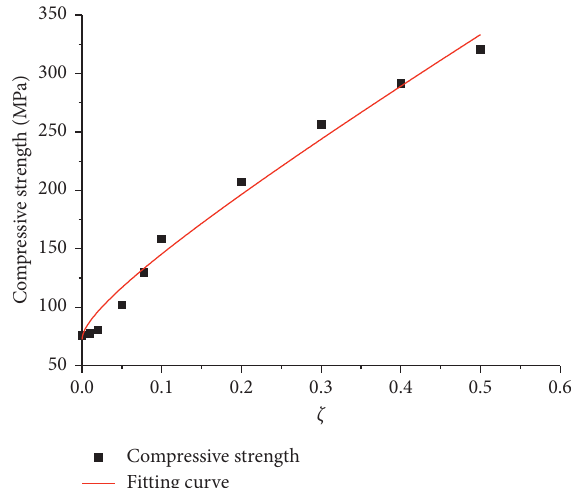
Figure 25: Fitting curve of compressive strength of CFST